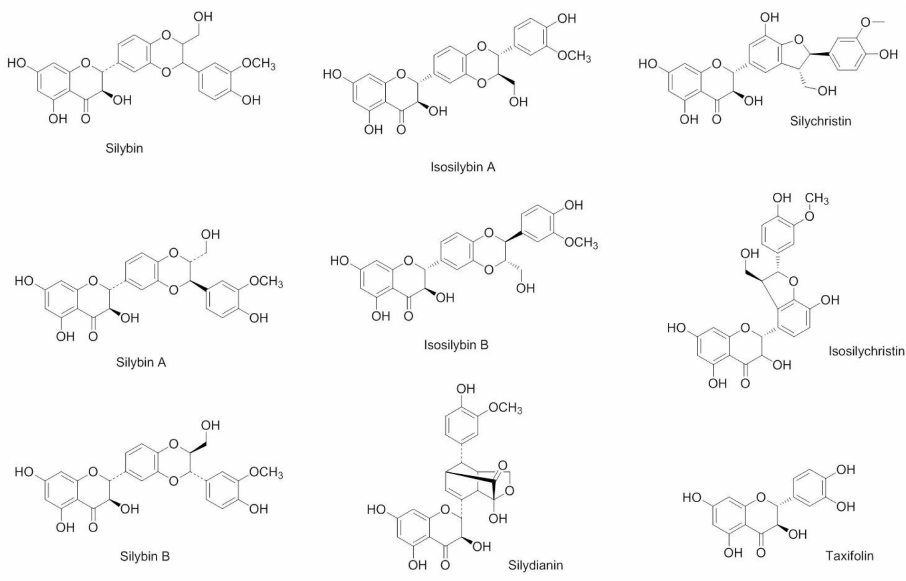
Figure 1. Silymarin constituents investigated in this study.